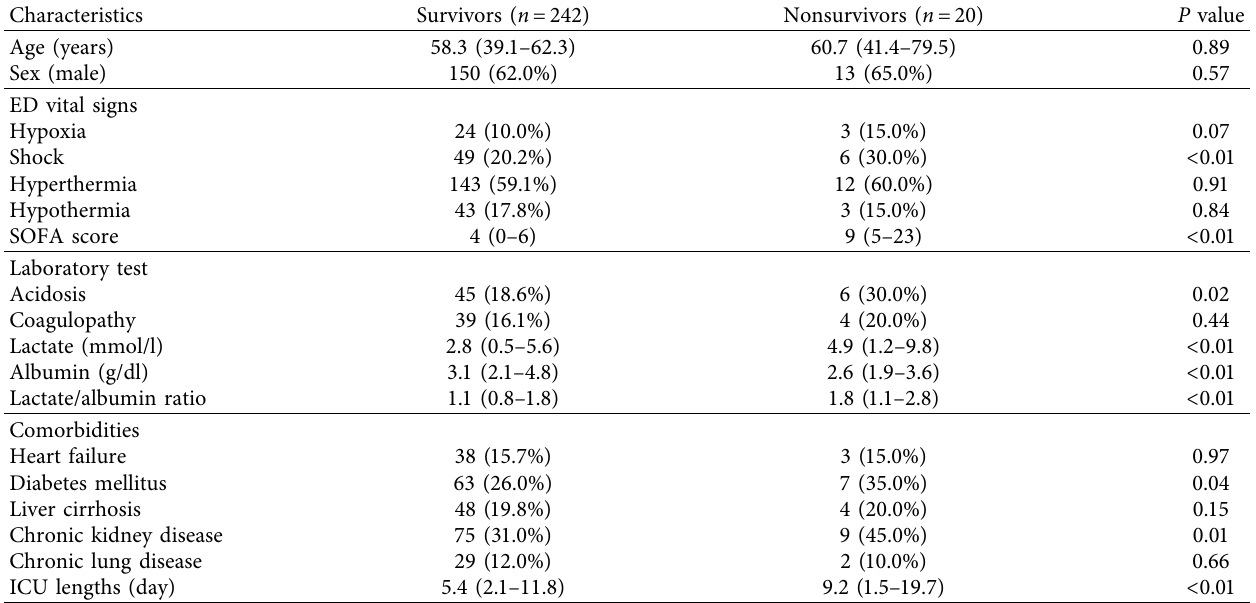
Table 1: Comparison of baseline characteristics between survival and nonsurvival groups.